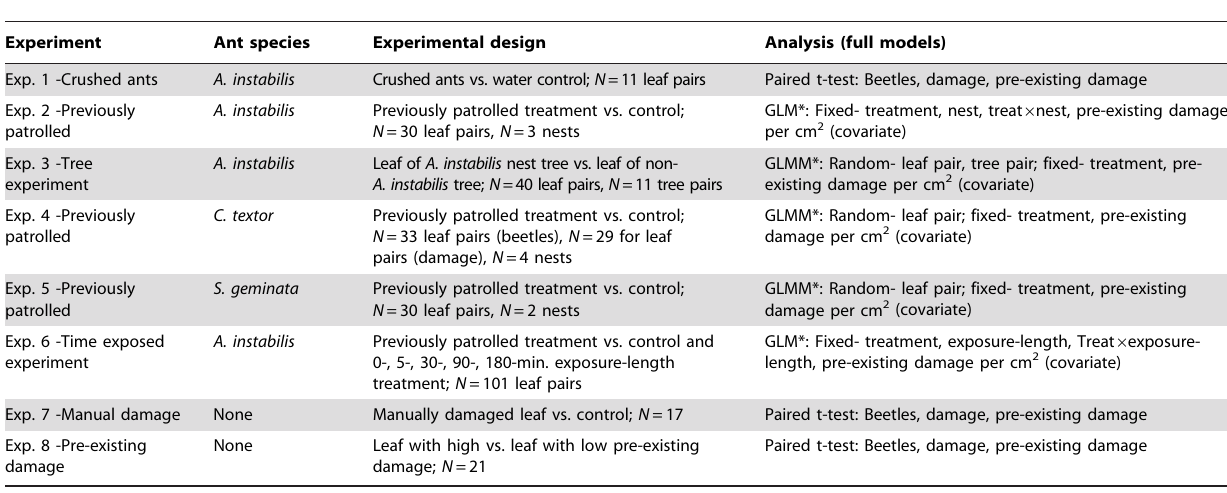
Table 1. Experiments performed to test the effects of ant semiochemicals and to test the effects of leaf damage on herbivore